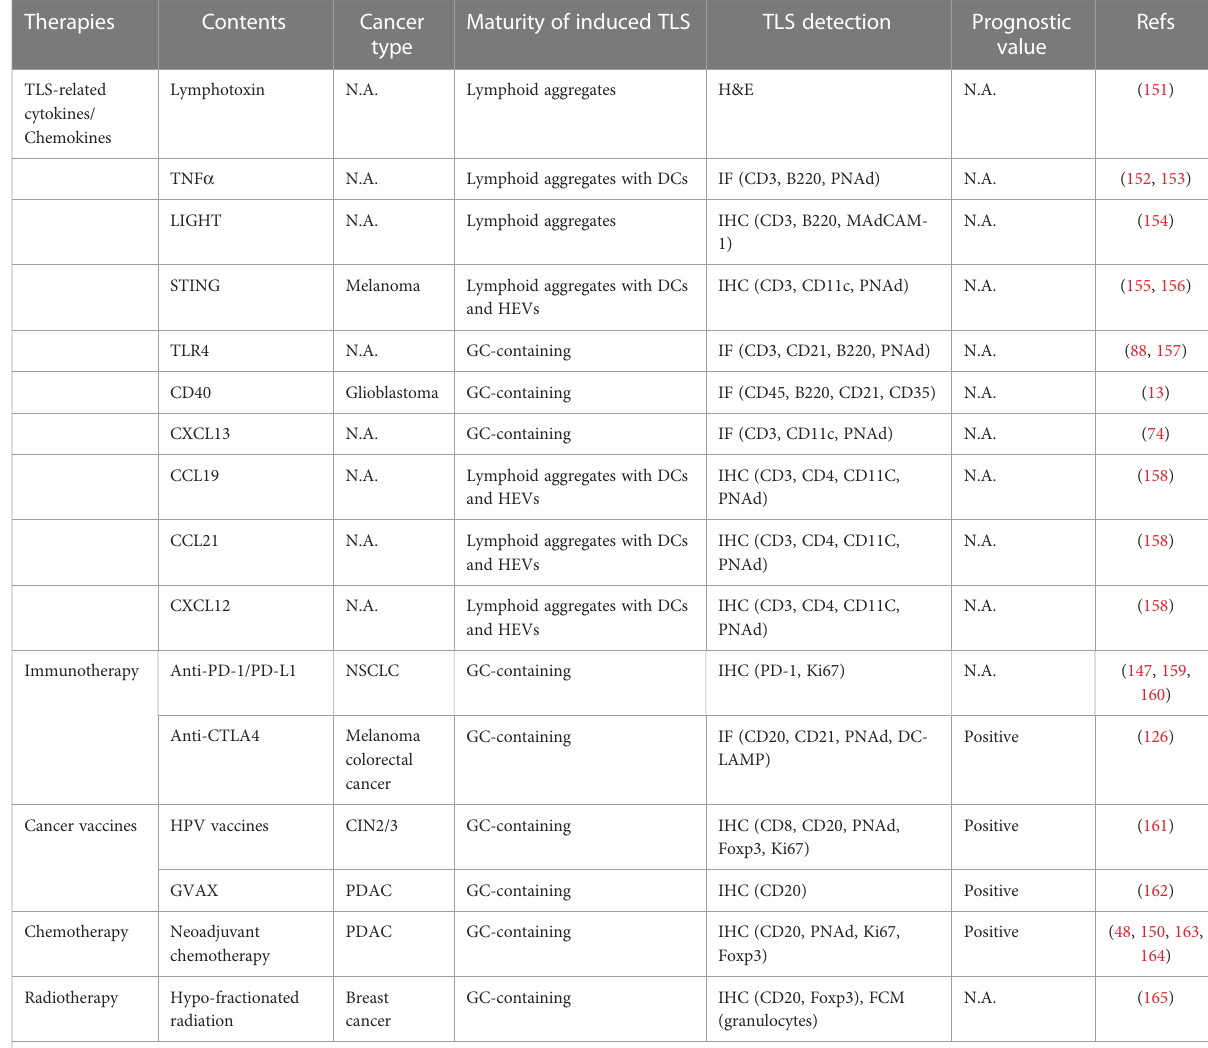
TABLE 3 Strategies for inducing TLS formation in cancer-bearing